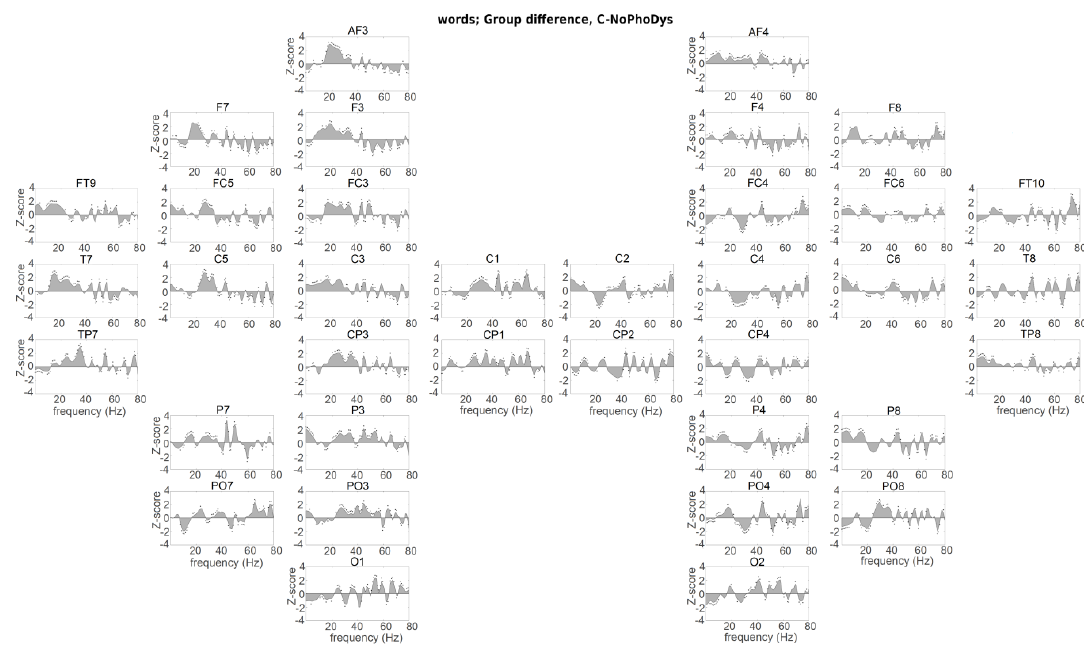
Figure 2. Hemispheric presentation of the group difference between controls and NoPhoDys for the word listening condition. The speech–brain entrainment on respective areas of controls is represented on the upper panel of plots and for dyslexics—on the lower panel of plots. Points indicate significant differences between the two groups (Kruskal–Wallis nonparametric test (KW test), bootstrap, p < 0.05).